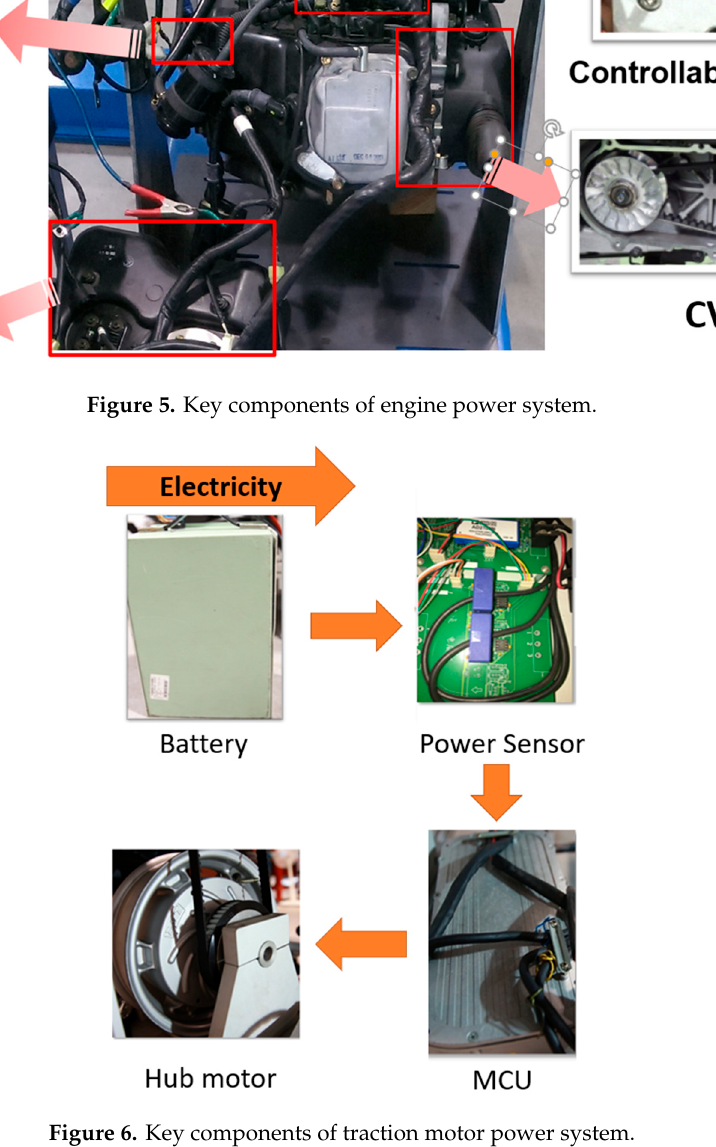
Figure 6. Key components of traction motor power system .